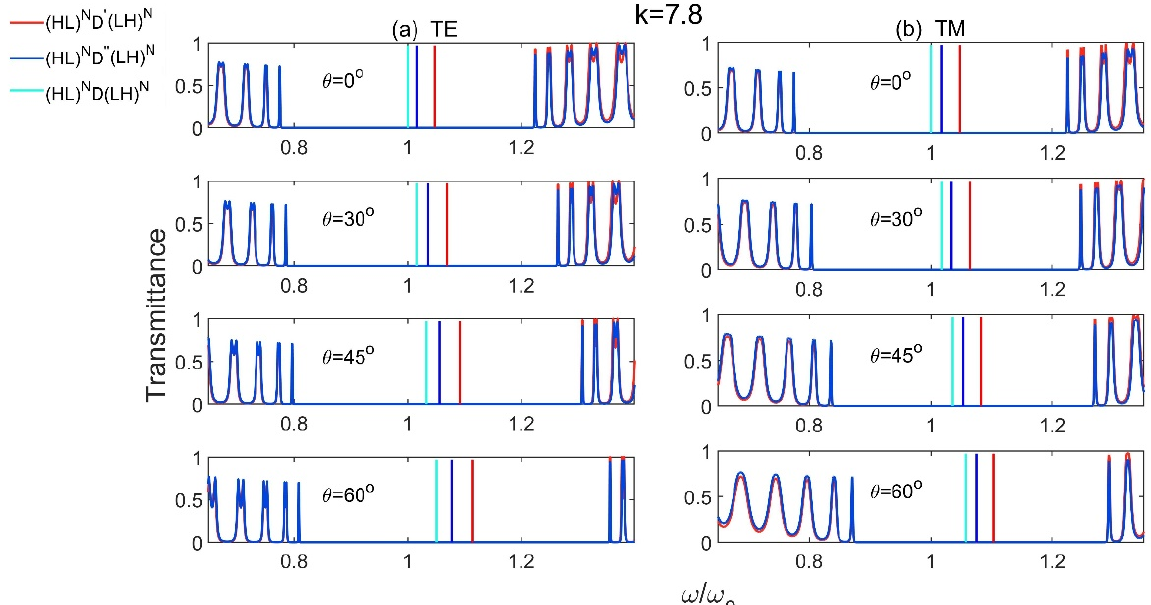
Figure 9. The transmission spectra of Model 5 ( HL ) N D (cid:48) ( LH ) N , Model 6 ( HL ) N D (cid:48)(cid:48) ( LH ) N and the reference Model ( HL ) N D ( LH ) N for different incident angles at slope k = 7.8 of the gradient defects for ( a ) TE and ( b ) TM polarizations.